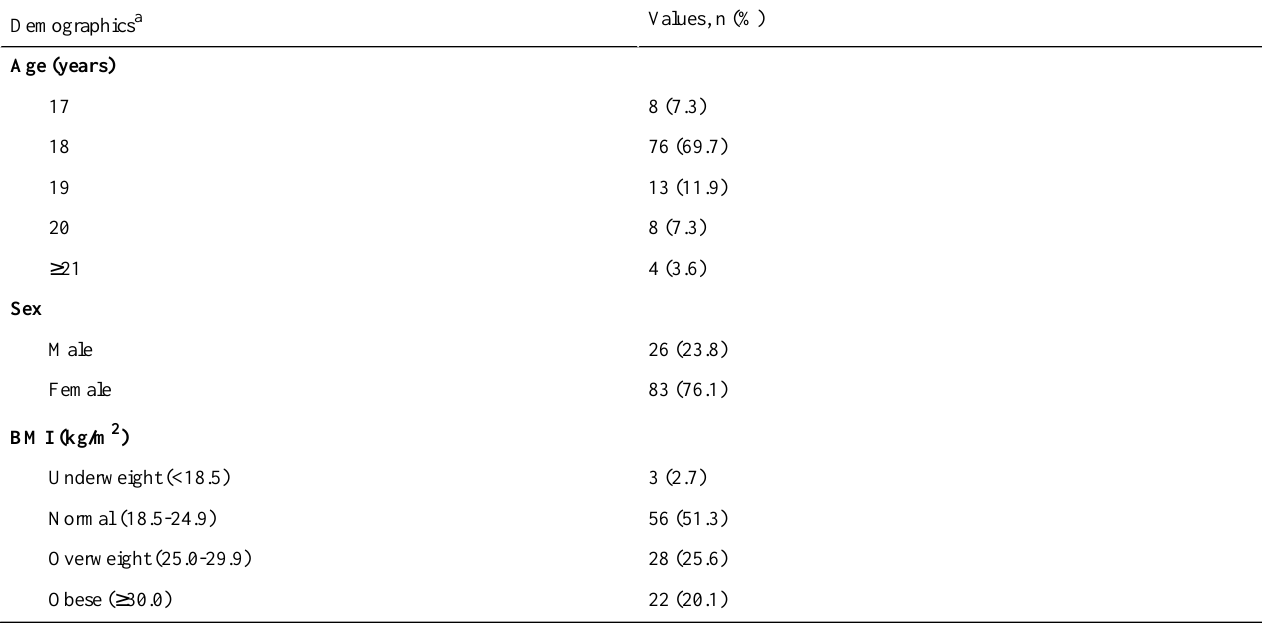
Table 1. Demographic characteristics of participants